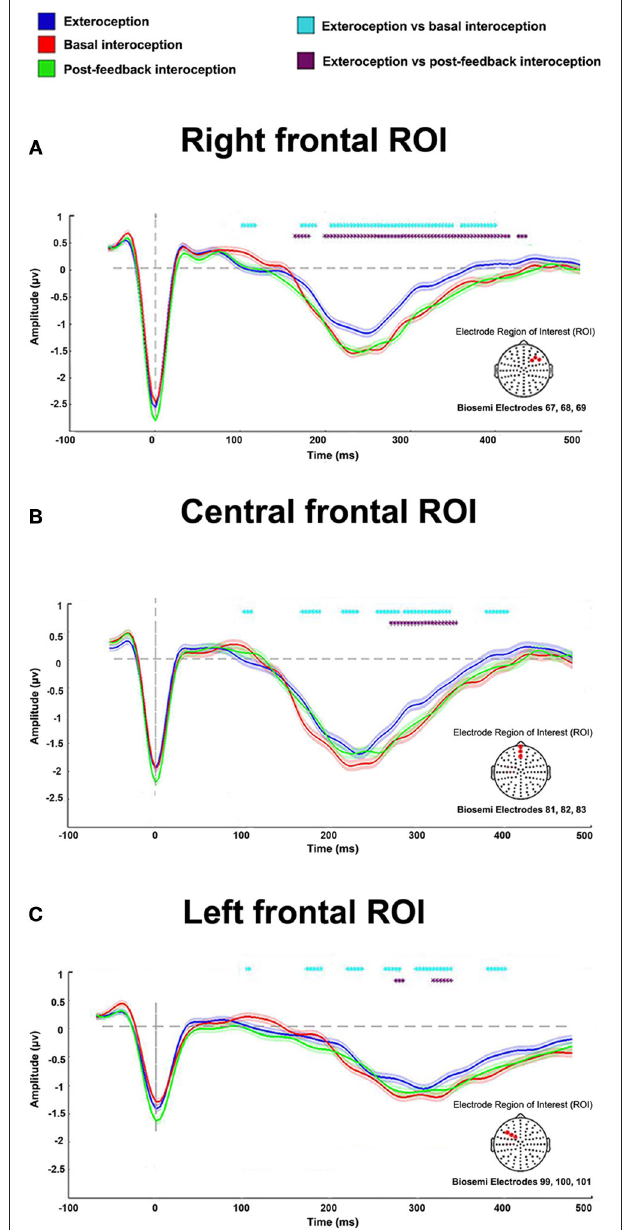
FIGURE 2 | HEP differences among conditions for the right, central, and left ROIs. Results show an enhanced modulation in all ROIs of the interoceptive conditions (basal and post-feedback) compared to the exteroceptive one. Dotted marks identify significant values between conditions ( p < 0.05). Differences not reaching five consecutive points were eliminated to avoid noisy results (i.e., differences that were only for one time point but not sustained in time, as done in previous reports, Couto et al., 2015b; García-Cordero et al., 2016); shadows indicate standard error of the mean